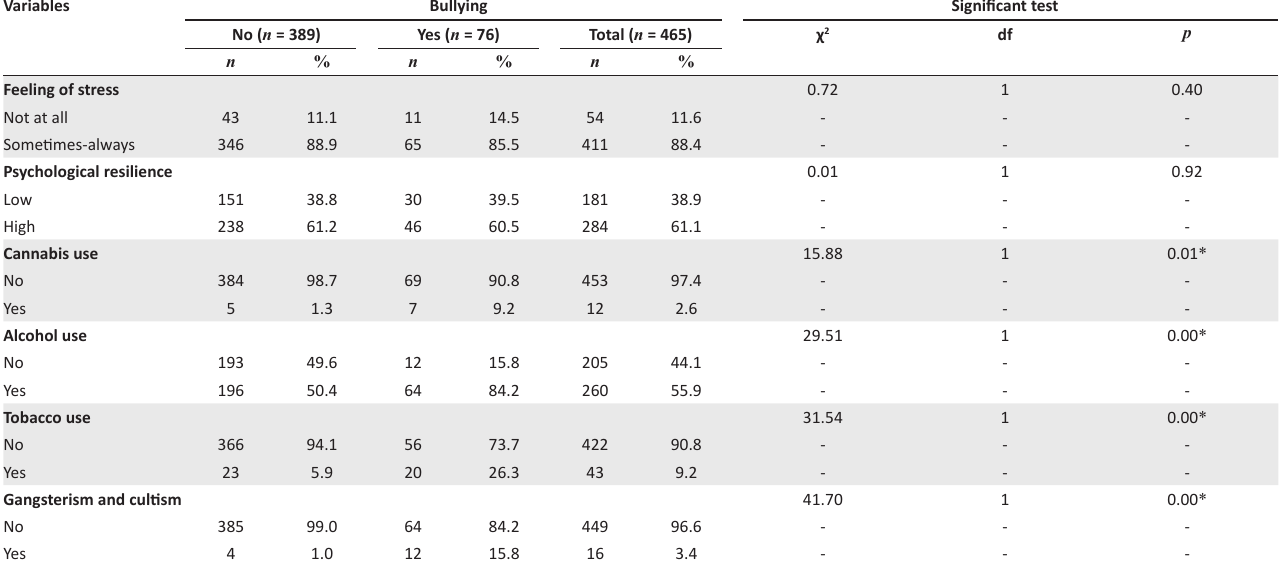
TABLE 2: Association of bullying with psychological factors and risky